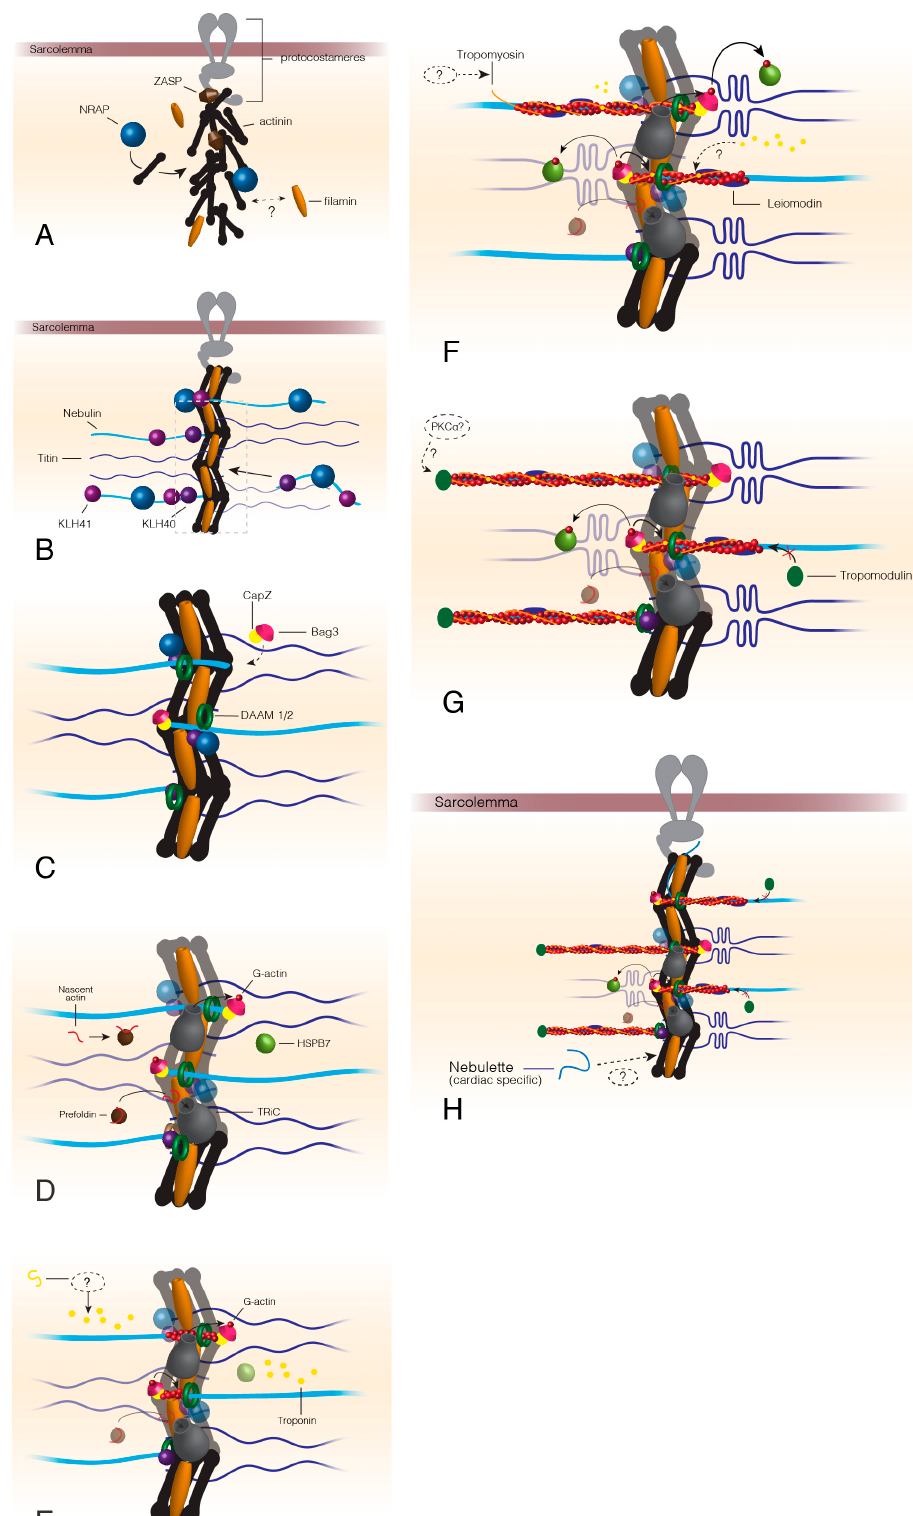
Figure 1. Thin filament assembly beginning at the formation of the Z-disc. The formation of the Z-disc begins once ZASP is recruited to the sarcolemma via proteins of the protocostameres ( A ). ZASP localization draws actinin, the actinin chaperone, NRAP, and filamin C to the protocostameres ( A ). Actinin and filamin C organization allows for nebulin/nebulette and titin incorporation into the premature Z-disc ( B ). KLHL40 and KLHL41 factors stabilize nebulin as it is incorporated into the Z- disc and prevent nebulin aggregation ( B ). Bag3 localizes CapZ to the Z-disc at approximately the